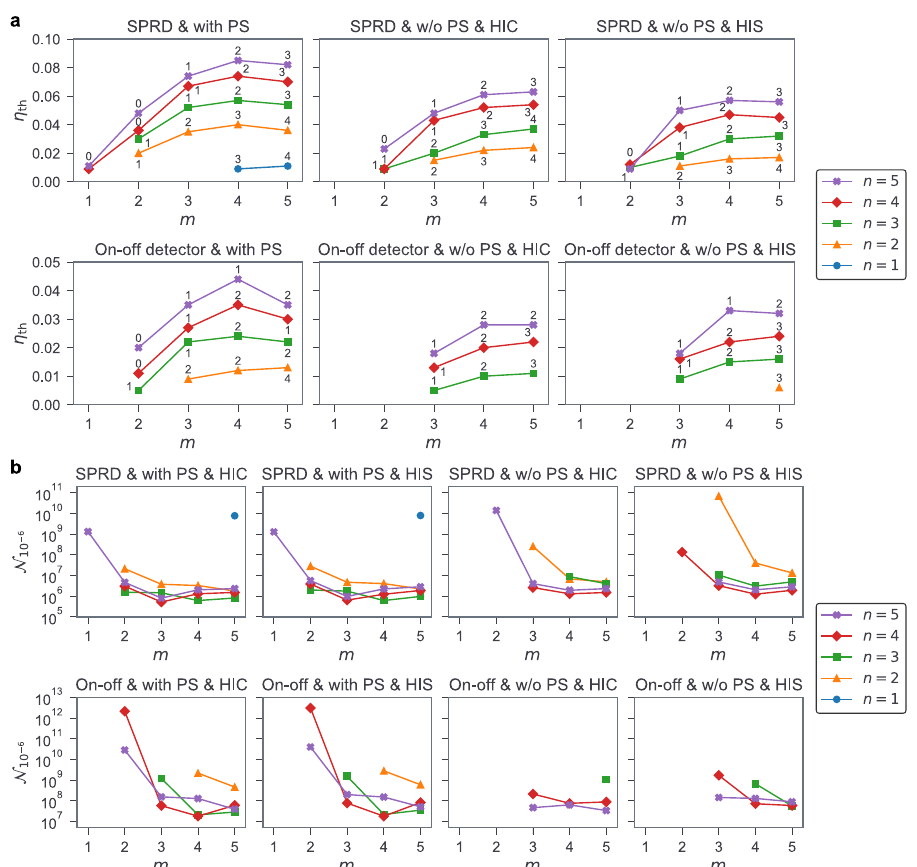
Fig. 5 Simulation results for PTQC. The loss thresholds η th ( a ) and resource overheads N encoding size ( n , m ), the type of detectors, the post-selection (PS) of star clusters, and the H -con fi guration. “ SPRD ” stands for single-photon is calculated at η = 0.01. The values of j are chosen to maximize η th and shown next to the data points in ( a ). The H - resolving detector. N 10 (cid:2) 6 con fi guration does not affect η th when star clusters are